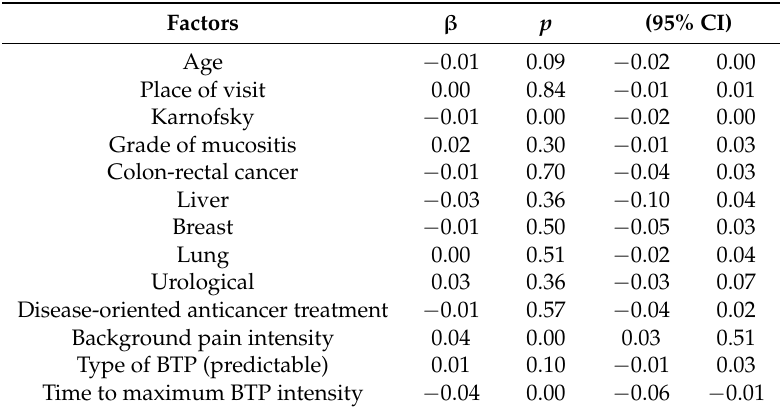
Table 3. Multivariate analysis for BTP intensity.